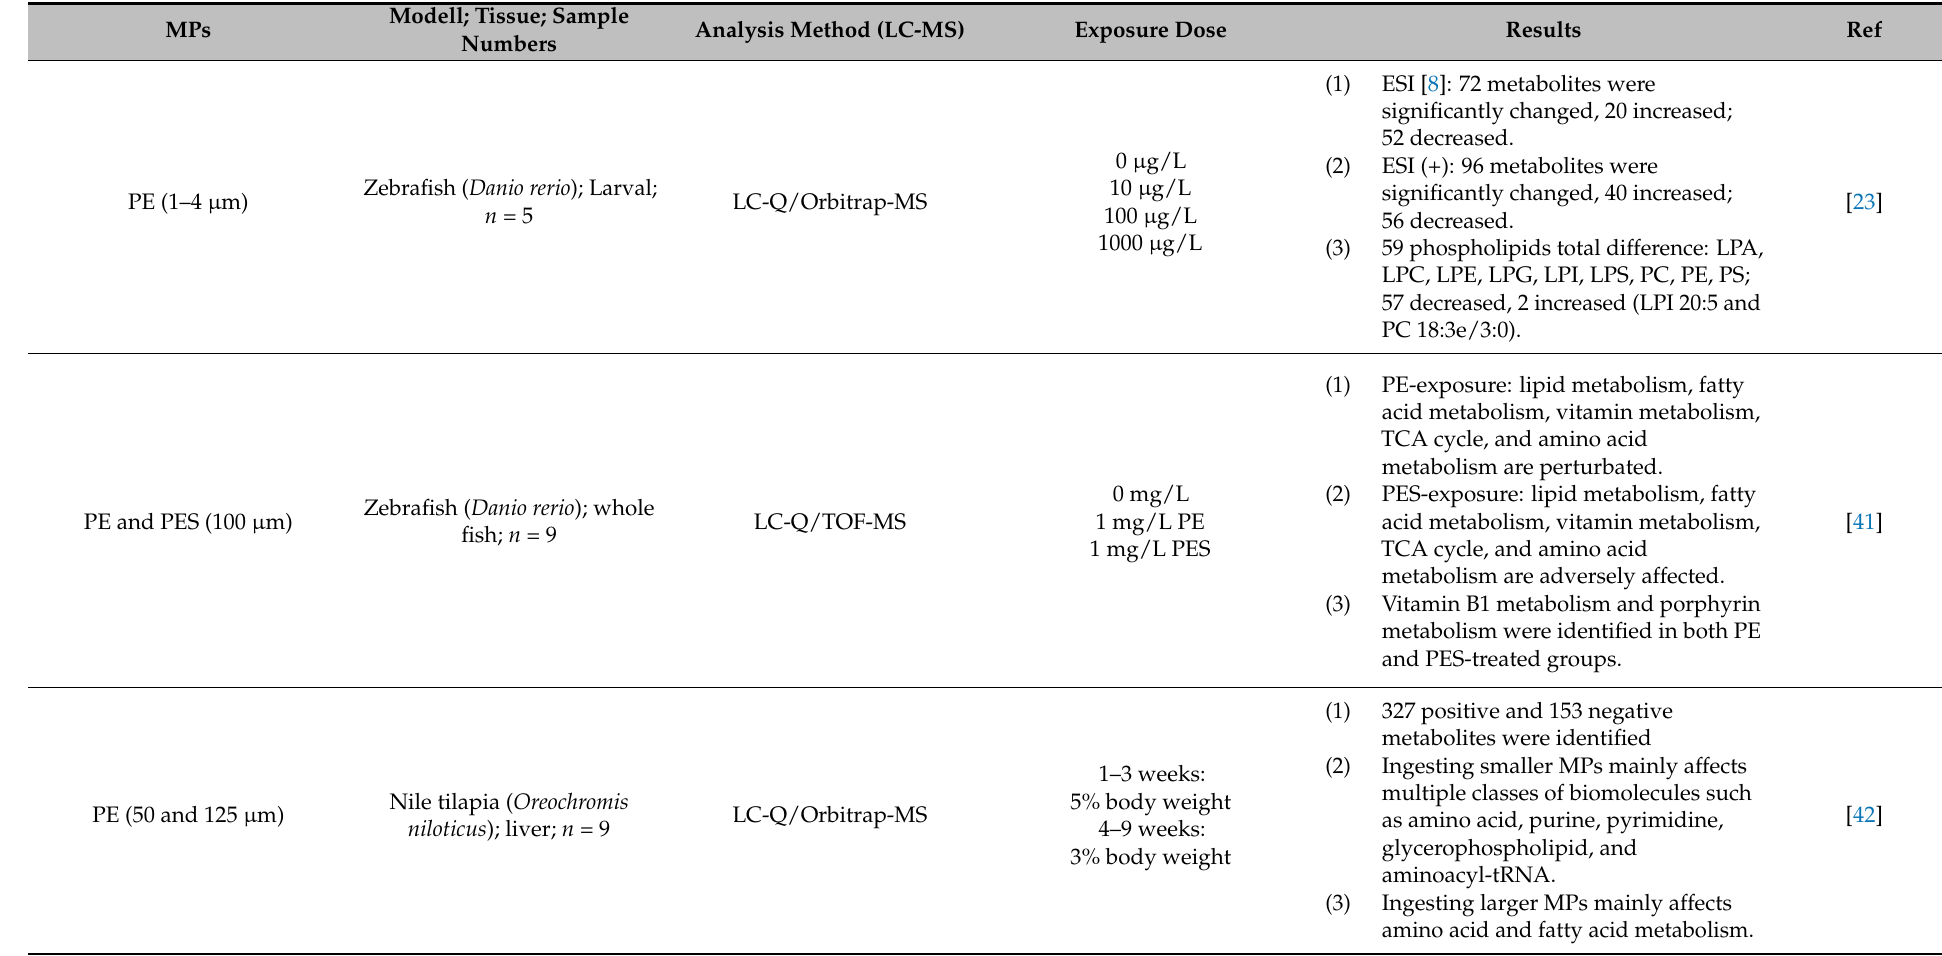
Table 2. The MPs, model, method, dose, and results for the studies cited for the MPs-induced untargeted